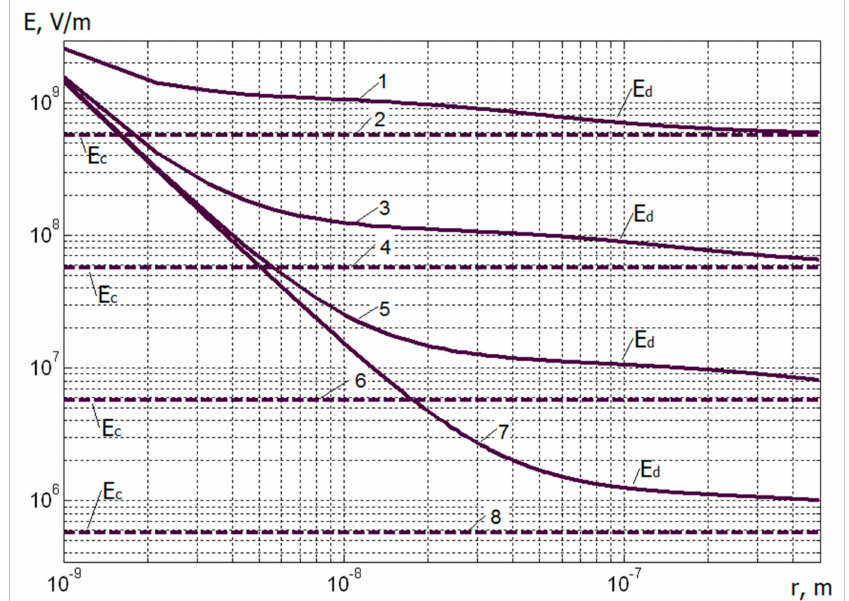
Figure 2. Dependences of the strengths of the electrostatic fields on the distance to the plane for various parameters. 1—E d , σ = 10 − 2 C / m 2 ; a = 4 nm; 2—E c , σ = 10 − 2 C / m 2 ; a = 4 nm; 3—E d , σ = 10 − 3 C / m 2 ; a = 0.04 µ m; 4—E c , σ = 10 − 3 C / m 2 ; a = 0.04 µ m; 5—E d , σ = 10 − 4 C / m 2 ; a = 0.13 µ m; 6—E c , σ = 10 − 4 C / m 2 ;